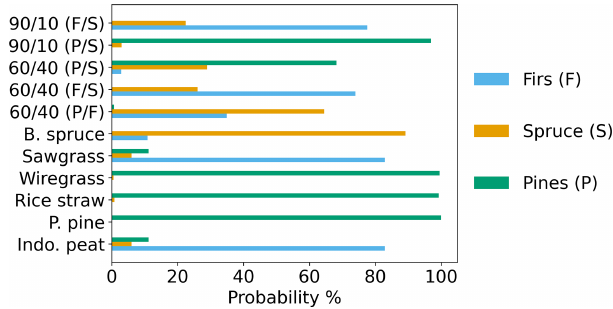
Figure 9. Spruce overlap with firs based on the PC combination used.